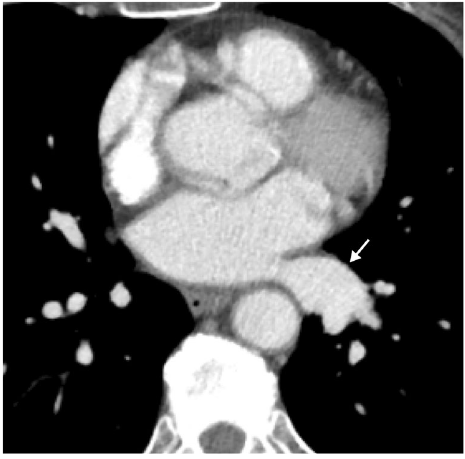
Fig. 14 Pulmonary vein varix. Axial contrast-enhanced CT image dem- onstrated a pulmonary vein varix ( white arrow ); note its proximity to the insertion in the left atrium. Varices can be saccular, tortuous, or confluent, with confluent being the most